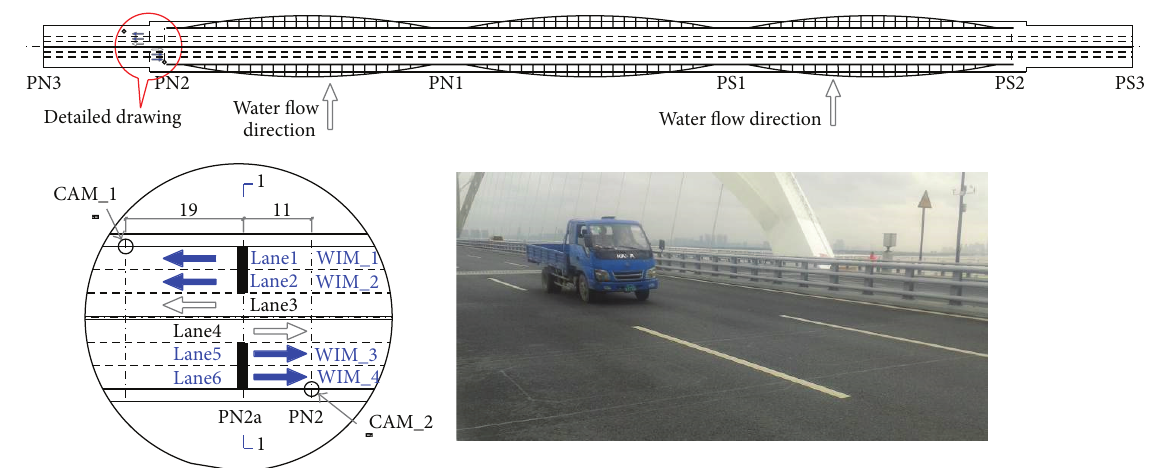
Figure 2: Installation positions of vehicle load acquisition system on bridge.